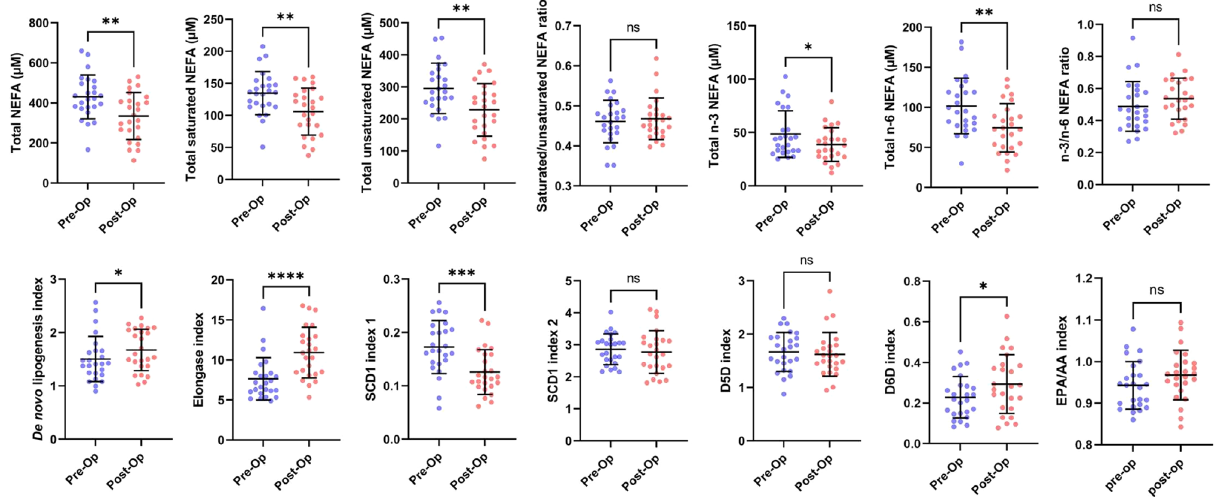
Figure 4. Mean plasma NEFA indices and ratios in participants before (Pre-Op) and 9 months after (Post-Op) bariatric surgery. Error bars show the mean values ± standard deviation. The p-values were calculated using paired T-test. Statistical significance is indicated as: ns, not significant (p > 0.05), *p ≤ 0.05 and **p ≤ 0.01, ***p ≤ 0.001 and ****p ≤